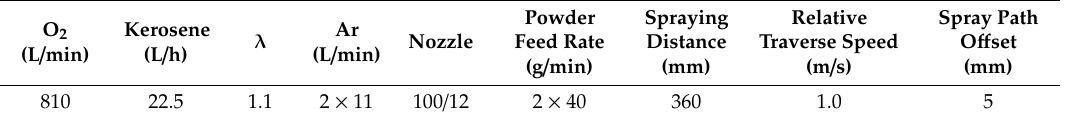
Table 1. High-velocity-oxygen-fuel (HVOF) coating parameters of CrFeCoNi feedstock powder. O 2 (L /